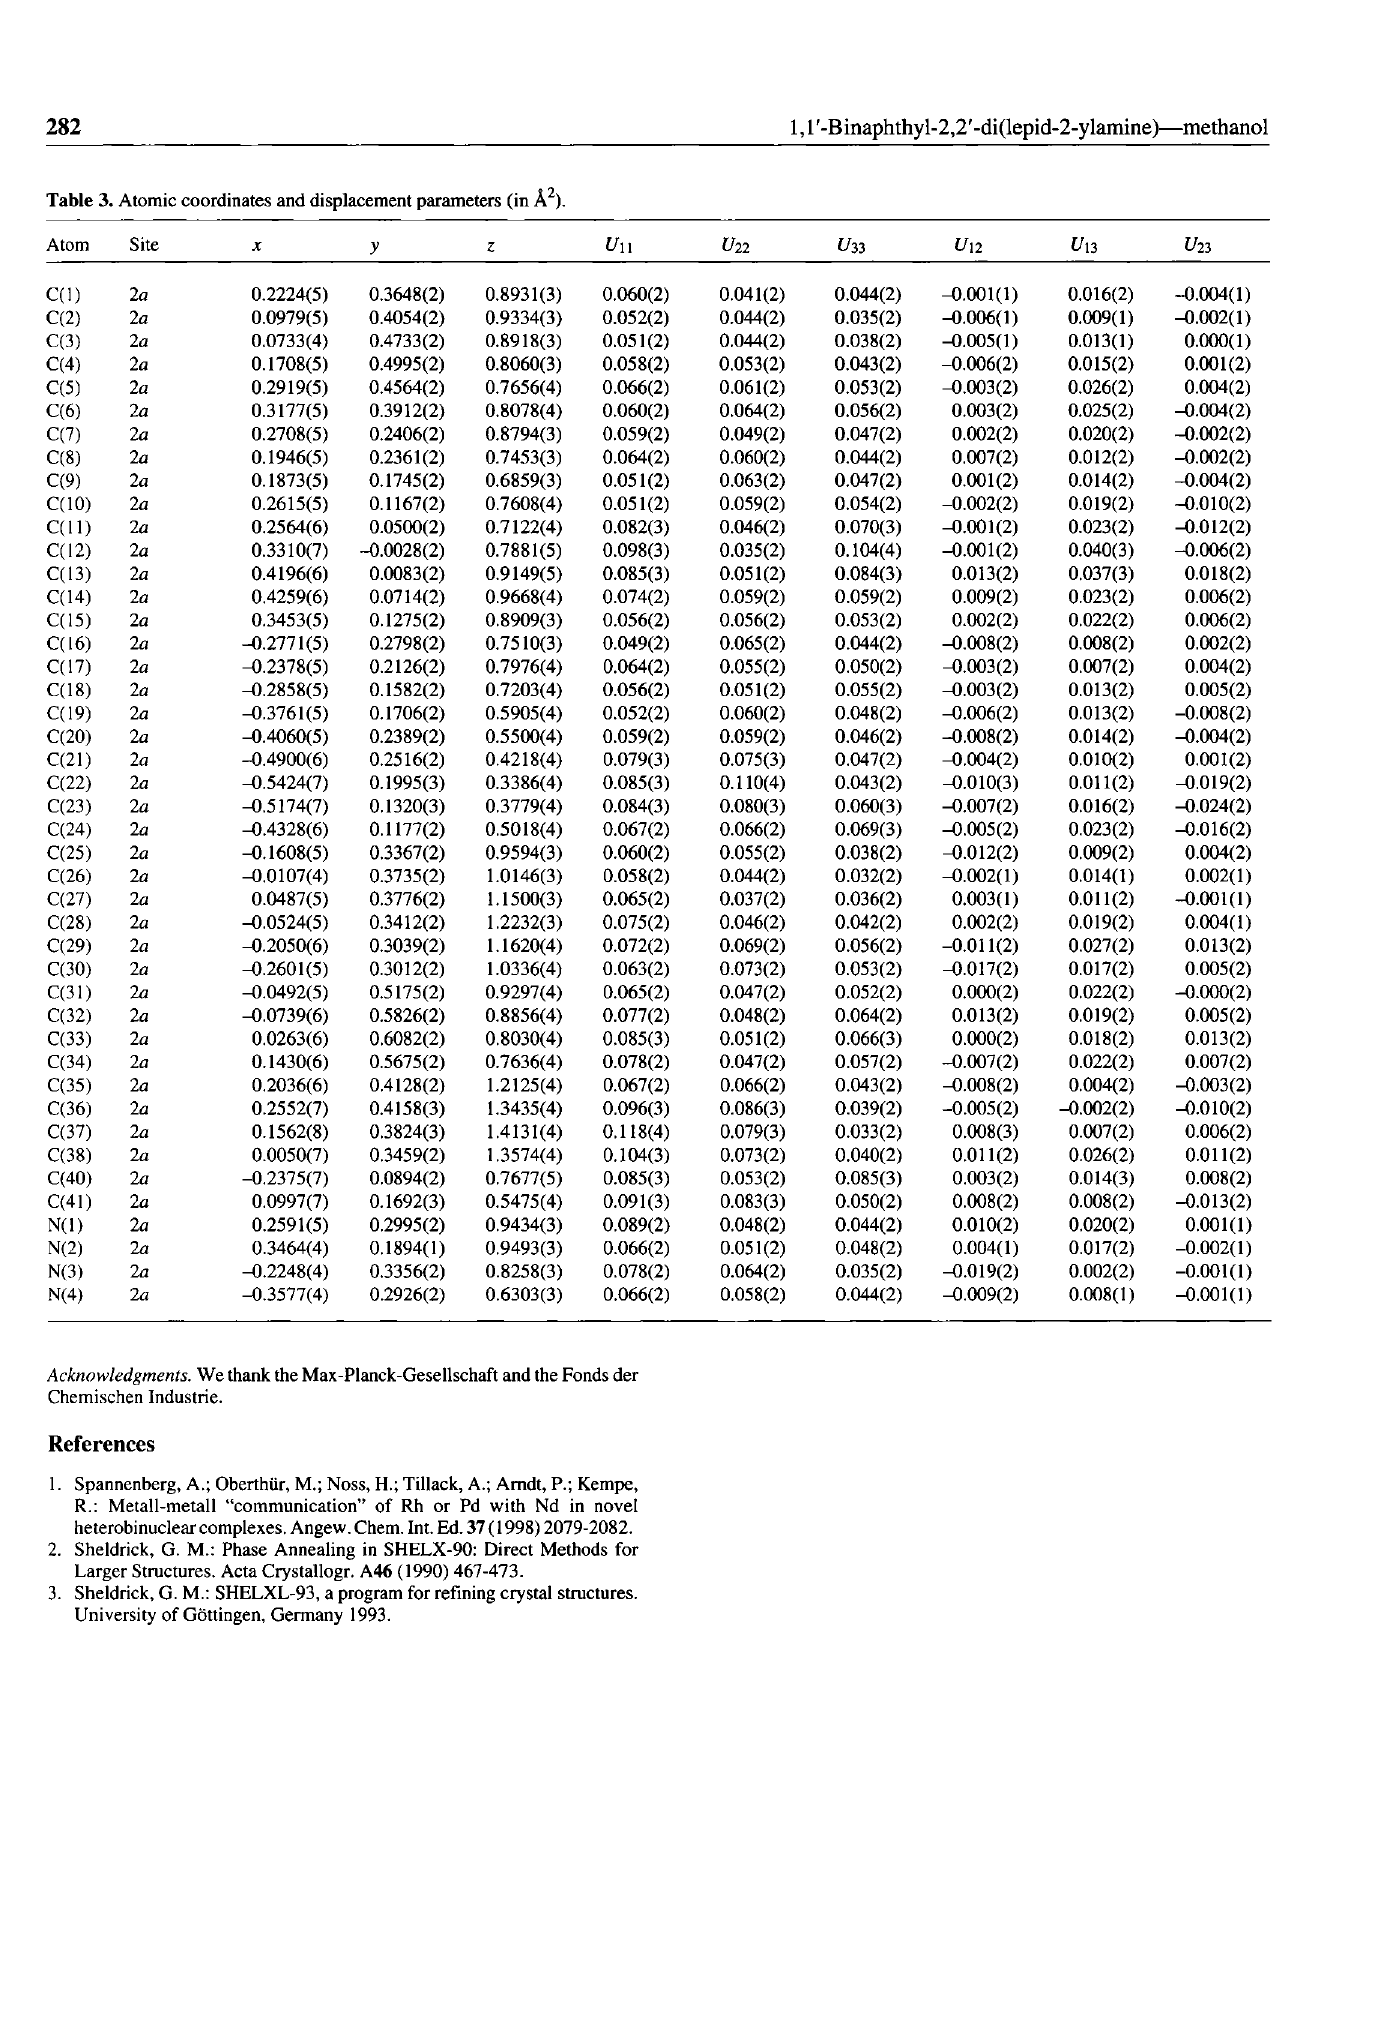
Table 3. Atomic coordinates and displacement parameters (in A 2